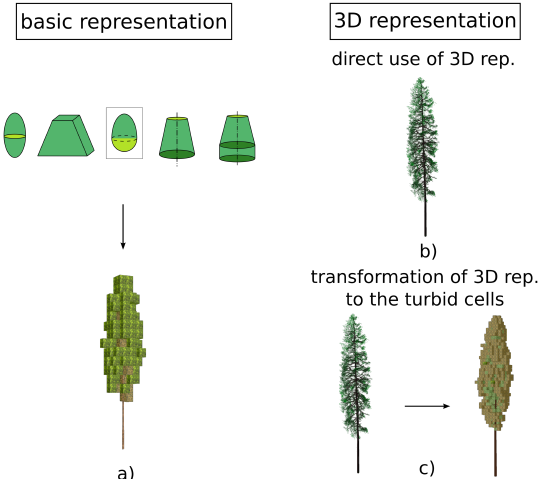
Figure 1. Three approaches for constructing trees using Discrete Anisotropic Radiative Transfer (DART): ( a ) creation of geometric crown shapes (basic representation) in DART, ( b ) import of external realistic 3D objects, and ( c ) transformation of realistic 3D tree objects into turbid-cells (voxelated)